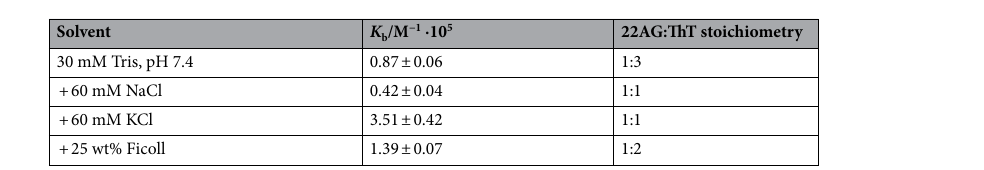
Table 1. Binding constants and stoichiometries for the 22AG:ThT complex formation at various solution conditions ( p = 1 bar, T = 25 °C).